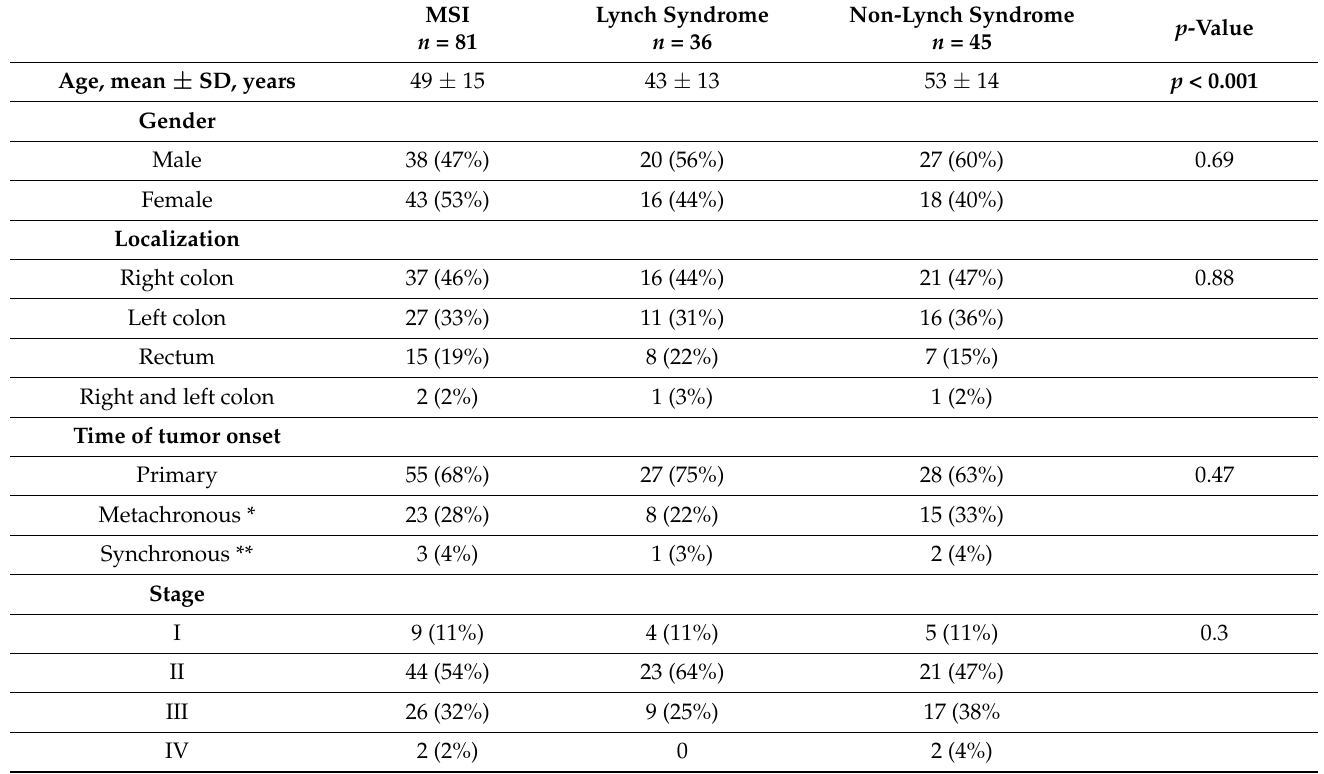
Table 2. Clinical and morphological data of patients with Lynch syndrome and MSI in sporadic